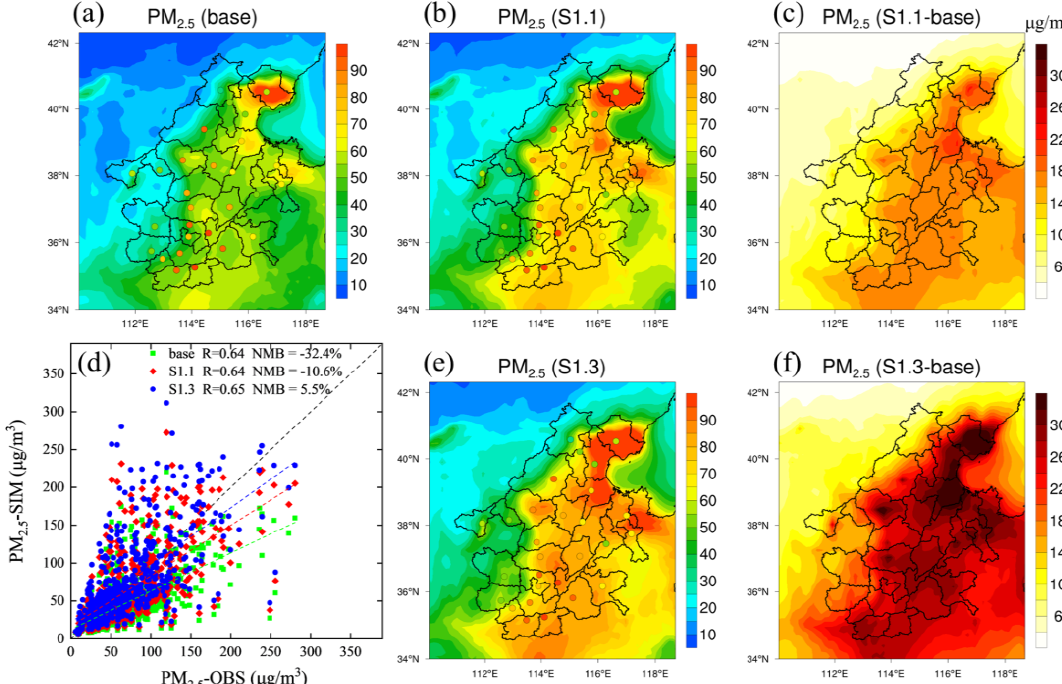
Figure 9. Spatial distributions of the average PM 2 . 5 concentrations over the BTH2 + 26 cities during the period from 6 to 30 December 2018 for the (a) base, (b) S1.1, and (e) S1.3 scenarios as well as (c) the absolute difference between the S1.1 and base scenarios and (f) the absolute difference between the S1.3 and base scenarios. Among them, the PM 2 . 5 concentrations from 22 to 26 December are not included due to the missing observational data. (d) Scatterplots and linear regressions of observed (OBS) and simulated (SIM) daily PM 2 . 5 concentrations for all of the BTH2 + 26 cities during the above time period under the base, S1.1, and S1.3